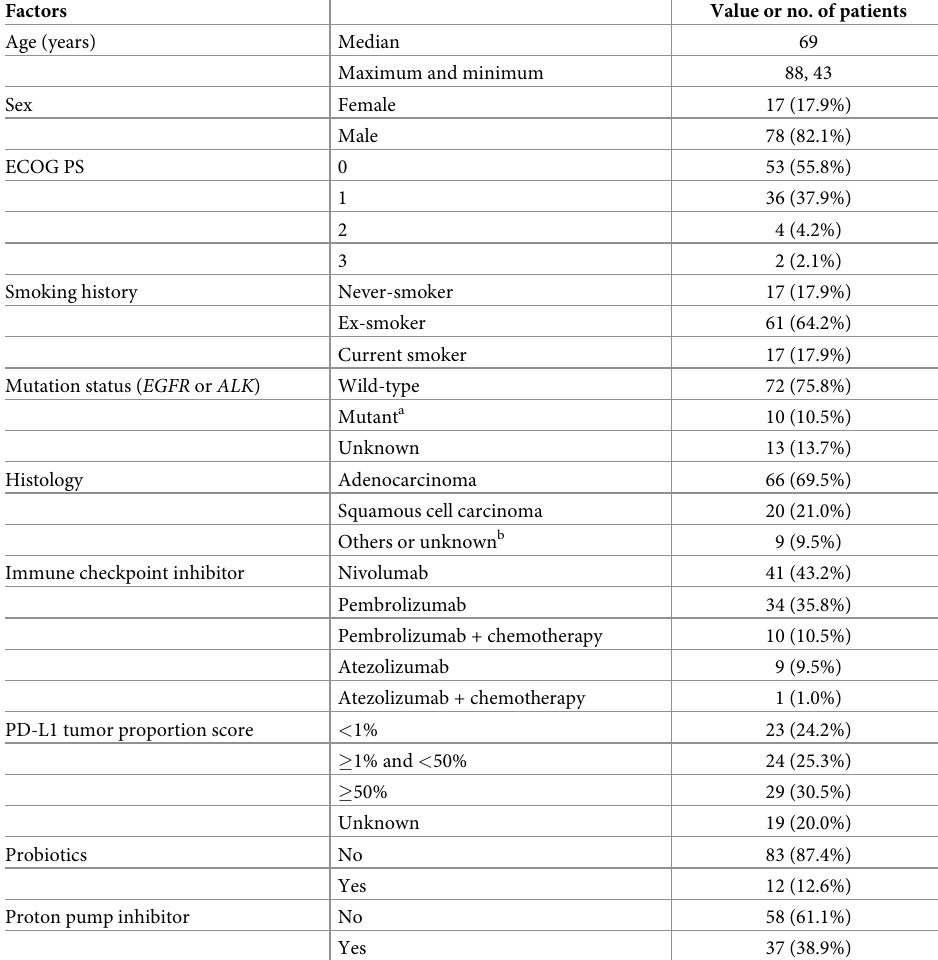
Table 1. Clinicopathological characteristics of all patients ( N = 95).